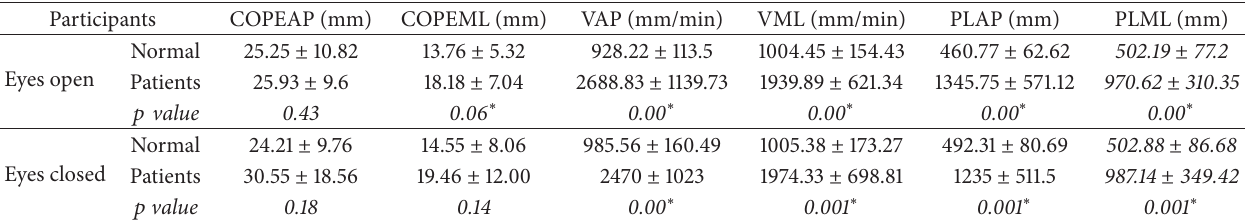
Table 2: The mean values with standard deviation of the stability parameters of normal subjects and the